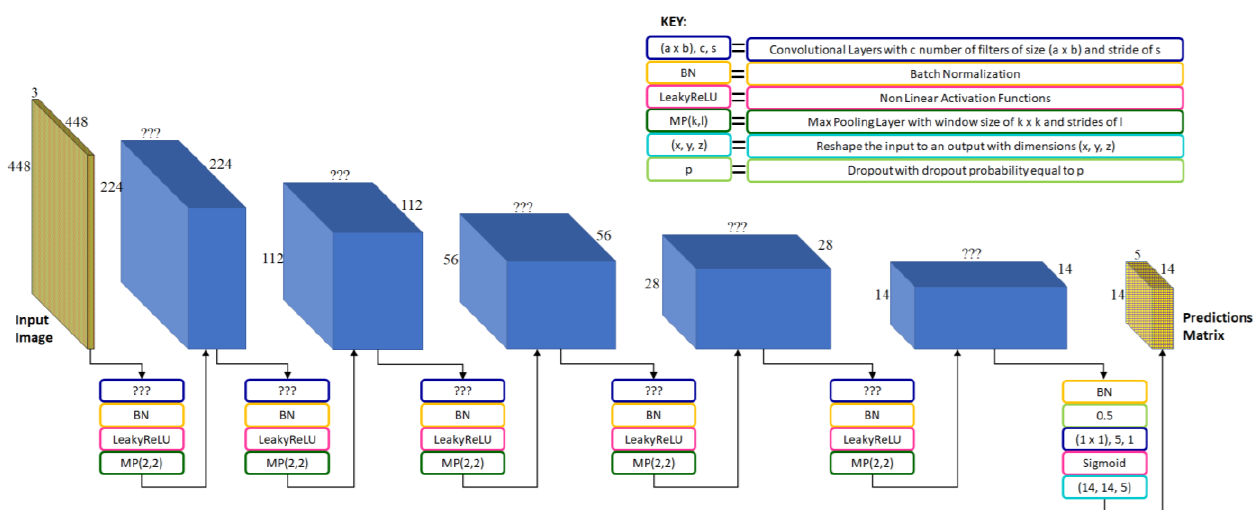
Figure 4. Basic structure used for designing CNN to detect soldering